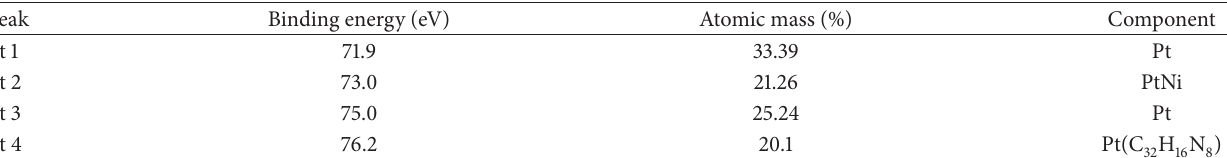
Table 2: Specification of platinum 4f peaks [23].